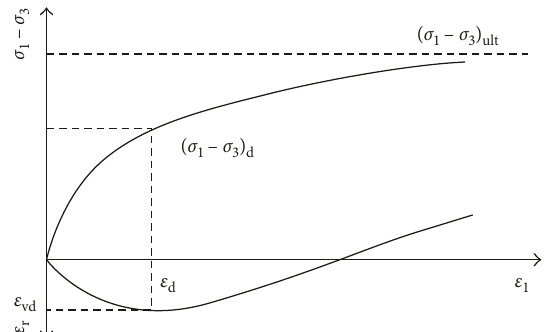
Figure 7: Schematic diagram of stress-strain curves of the Shen Zhujiang double yield surface model.